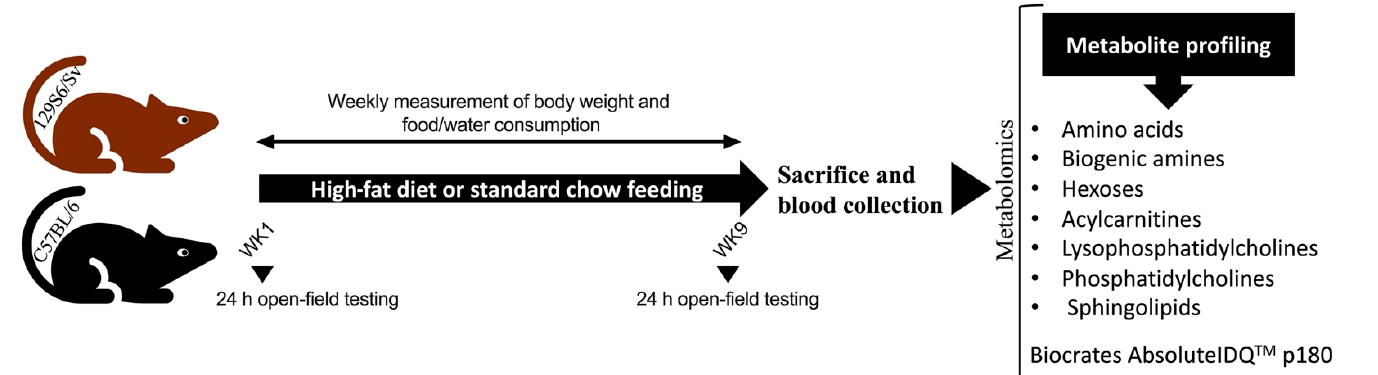
Figure 7. Schematic overview of experimental design. Bl6 and 129Sv mice were fed with a high-fat diet or standard chow for 9 weeks. Body weight and food and water consumption were measured weekly. Locomotor activity was assessed at the start of the dietary intervention and week 9. Subsequently, mice were sacrificed, and blood was collected for metabolomic analysis.